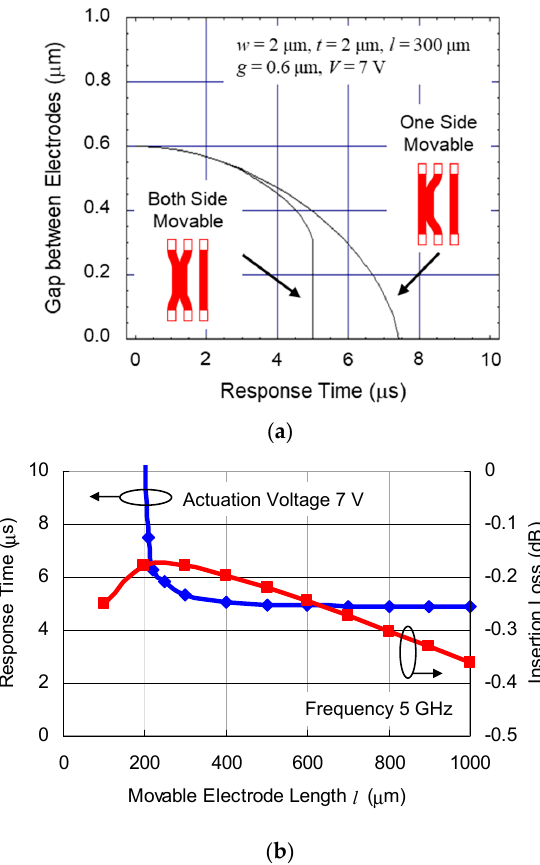
Figure 2. ( a ) Comparison of simulated response time between case of both side of electrodes movable and one side movable; ( b ) simulated response time and insertion loss as a function of length of movable electrode.